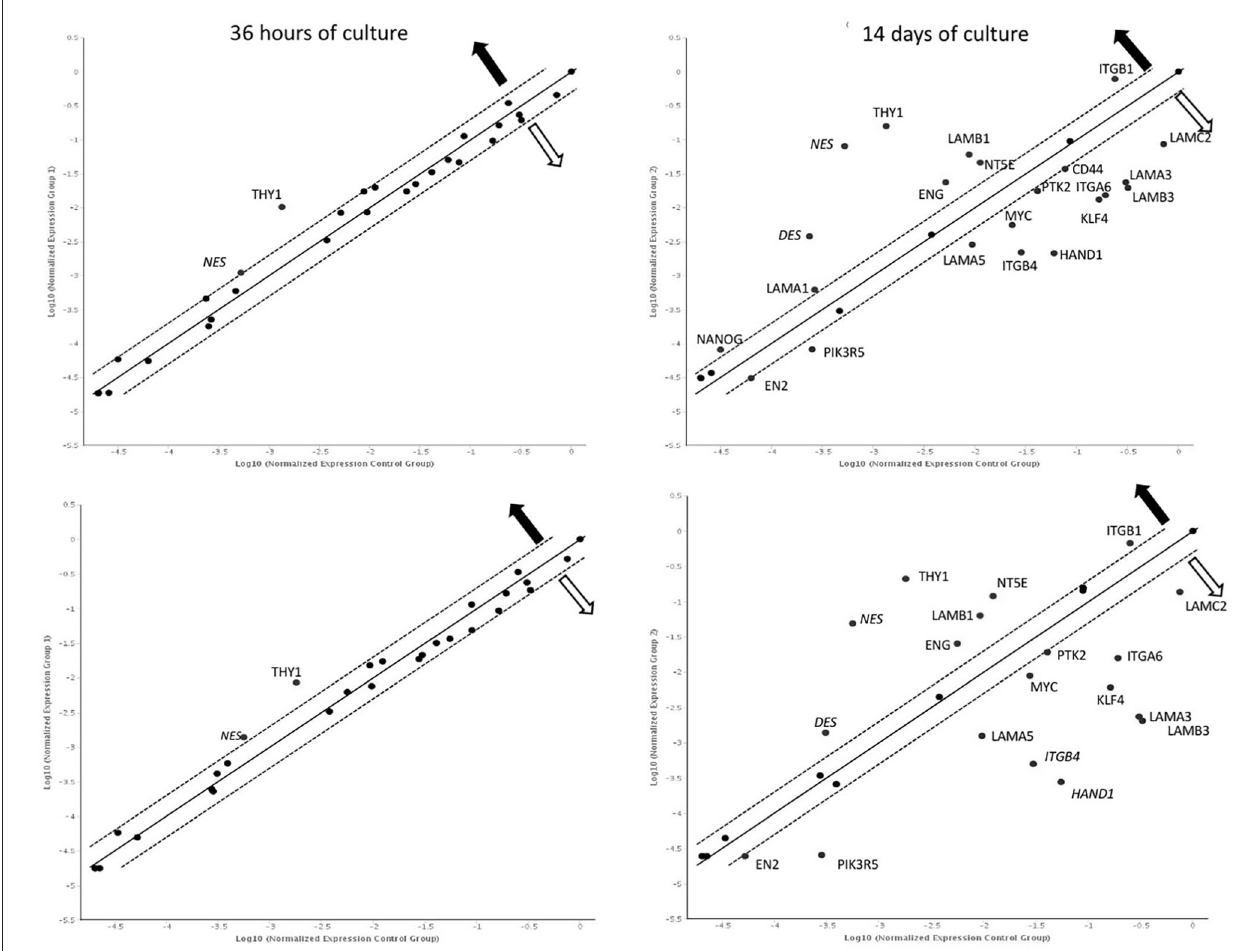
FIGURE 4 | Gene expression profile after 36h and 14 days of culture on uncoated (up) laminin 332-coated (down) plates comparing to 12h. Dotted line: expression changed 2-fold (statistically significant; p < 0.05); —overexpression